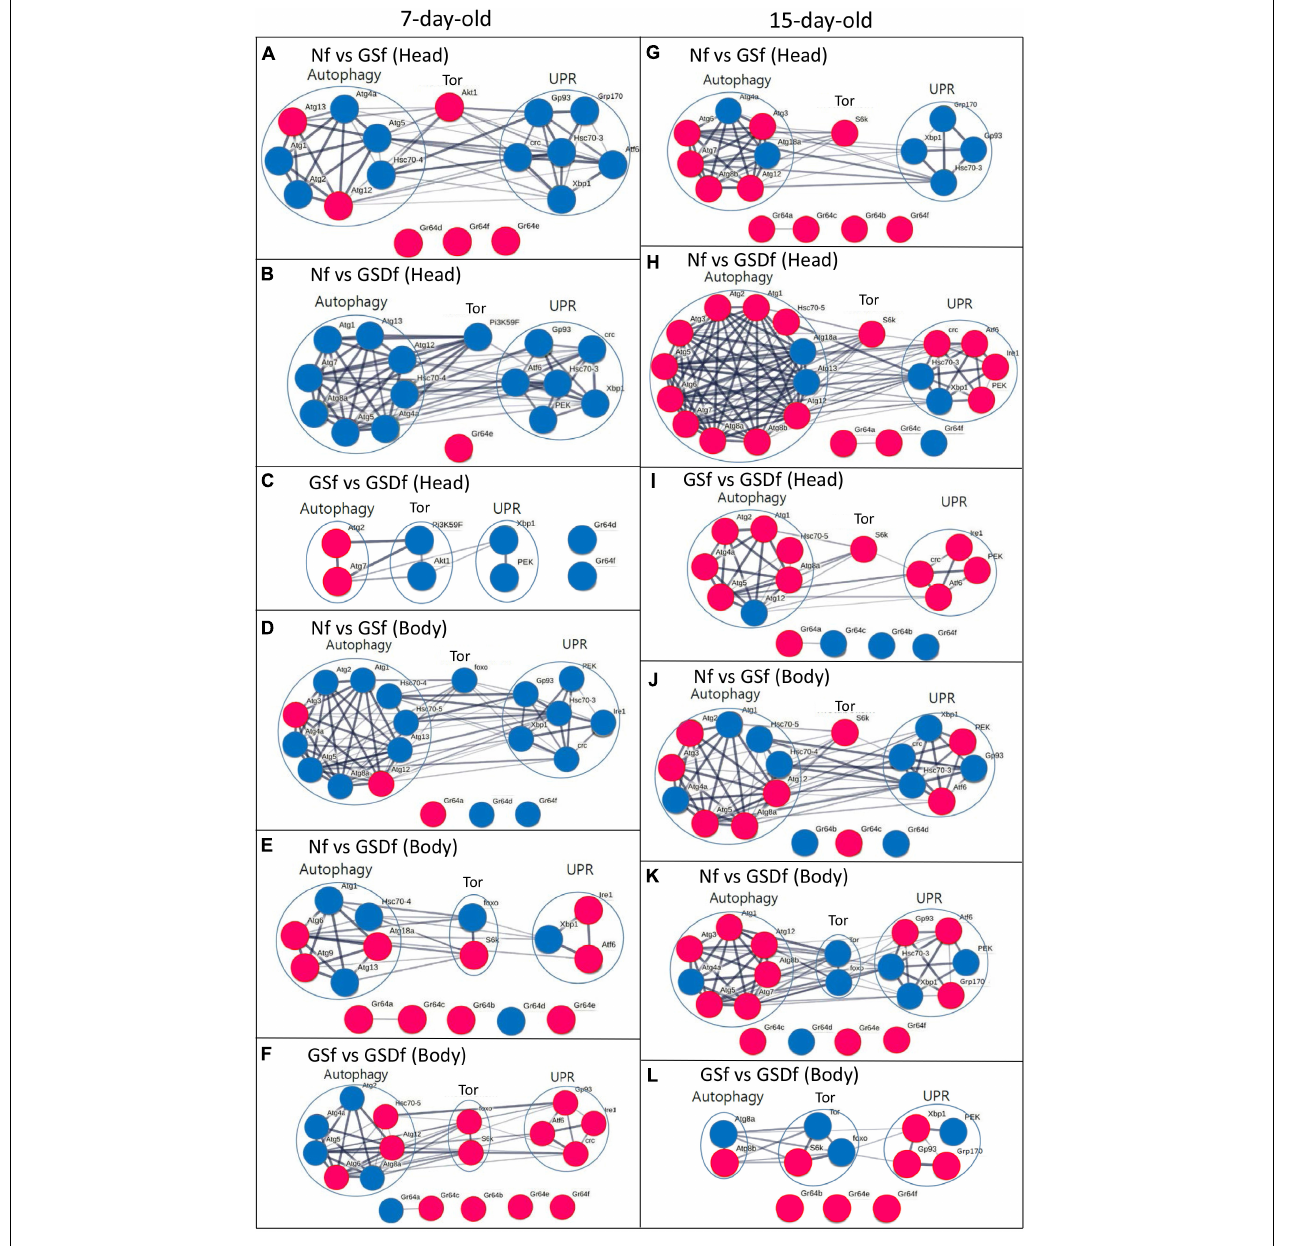
FIGURE 2 | Results of gene-to-gene interaction analysis of differentially expressed genes (DEGs) in autophagy-, Unfolded protein response (UPR)-, and Tor-signaling in the heads and bodies of 7- or 15-day-old Nf-, GSf-, and GSDf-reared Drosophila . Red circles indicate upregulated DEGs, while blue circles indicate downregulated DEGs. DEGs in the heads of 7-day-old GSf- (A) or GSDf-reared Drosophila (B) compared with those of Nf-reared Drosophila . DEGs in the heads of 7-day-old GSDf-reared Drosophila compared with those of GSf-reared Drosophila (C) . DEGs in the body of 7-day-old GSf- (D) or GSDf-reared Drosophila (E) compared with that of Nf-reared Drosophila . DEGs in the heads of 7-day-old GSDf-reared Drosophila compared with those of GSf-reared Drosophila (F) . DEGs in the heads of 15-day-old GSf- (G) or GSDf-reared Drosophila (H) compared with that of Nf-reared Drosophila . DEGs in the heads of 15-day-old GSDf-reared Drosophila compared with those of GSf-reared Drosophila (I) . DEGs in the bodies of 15-day-old GSf- (J) or GSDf-reared Drosophila (K) compared with those of Nf-reared Drosophila . DEGs in the bodies of 15-day-old GSDf-reared Drosophila compared with that of GSf-reared Drosophila (L) .